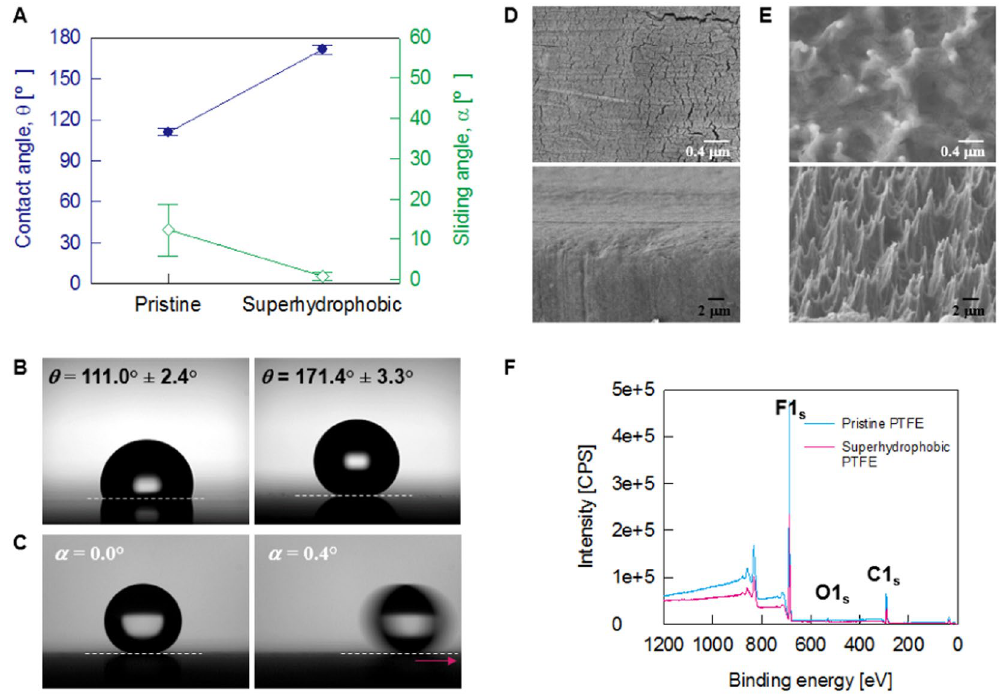
Figure 1. Wetting behaviors and surface characteristics of the fabricated superhydrophobic PTFE sheets. ( A ) Variations of the contact angle (marked by blue circle) and the sliding angle (marked by green diamond) of the pristine PTFE and the fabricated superhydrophobic PTFE sheets. ( B ) Contact-angle images of the pristine PTFE sheet (left) and the superhydrophobic PTFE sheet (right). ( C ) Sliding angle images of the superhydrophobic PTFE sheet. Water droplet disappears when the inclined angle is approximately 0.4°. SEM images of ( D ) the pristine PTFE having a smooth surface and ( E ) the fabricated superhydrophobic PTFE having crown-shaped bumps. The top images are top-view images, and the bottom images are side-view images. ( F ) Broad spectra obtained by XPS analysis on the pristine PTFE sheets and the fabricated superhydrophobic PTFE